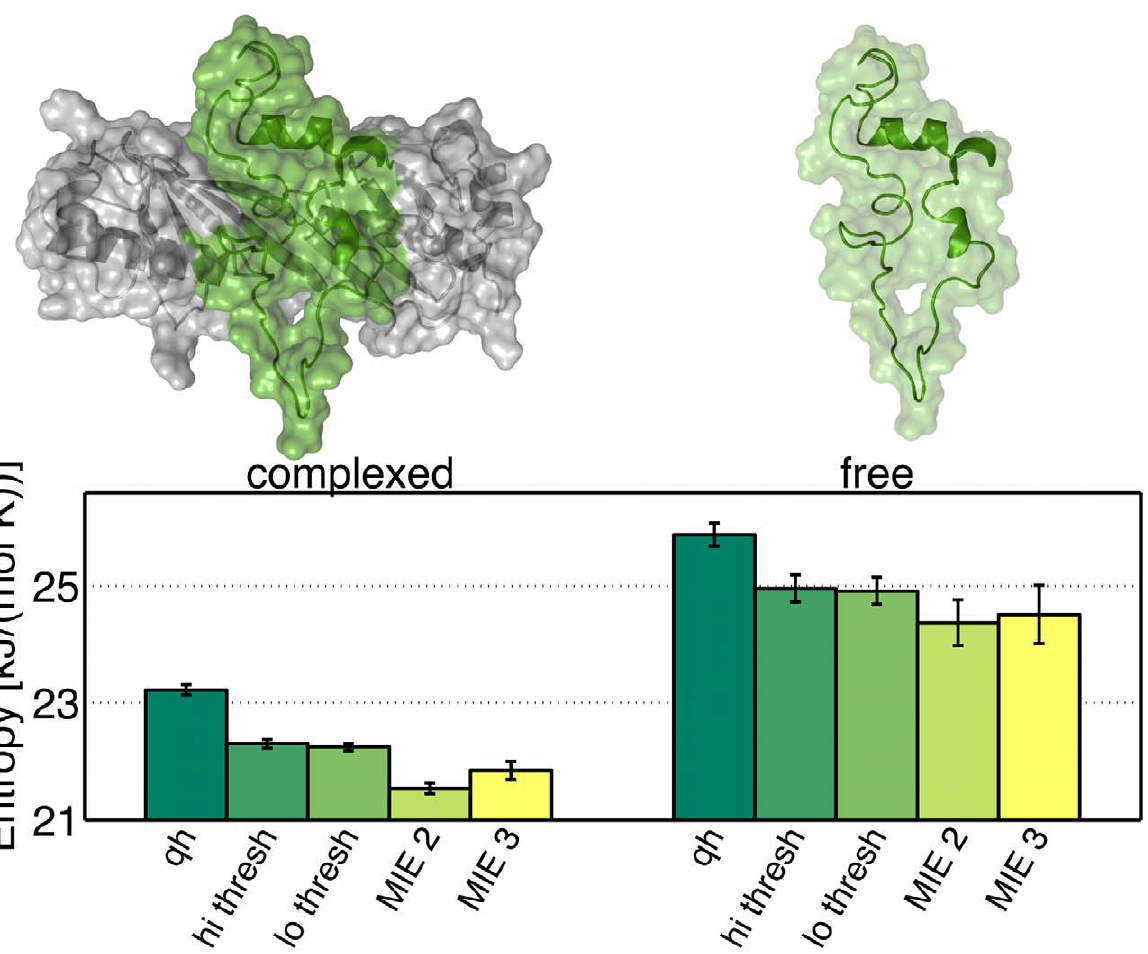
Figure 2. Entropy estimates for the TATA box binding protein (TBP) inhibitor in complex (left) and free (right). The following techniques are used: quasi-harmonic approximation (QH); FCA with subsequent density estimation using a high clustering threshold h (hi thresh) or, respectively, a low threshold (lo thresh); mutual information expansion of order 2 (MIE2) or, respectively, of order 3 (MIE3). The displayed entropy estimates are averages over five independent simulations of 100 ns each, the error bars indicate standard deviations of the mean.